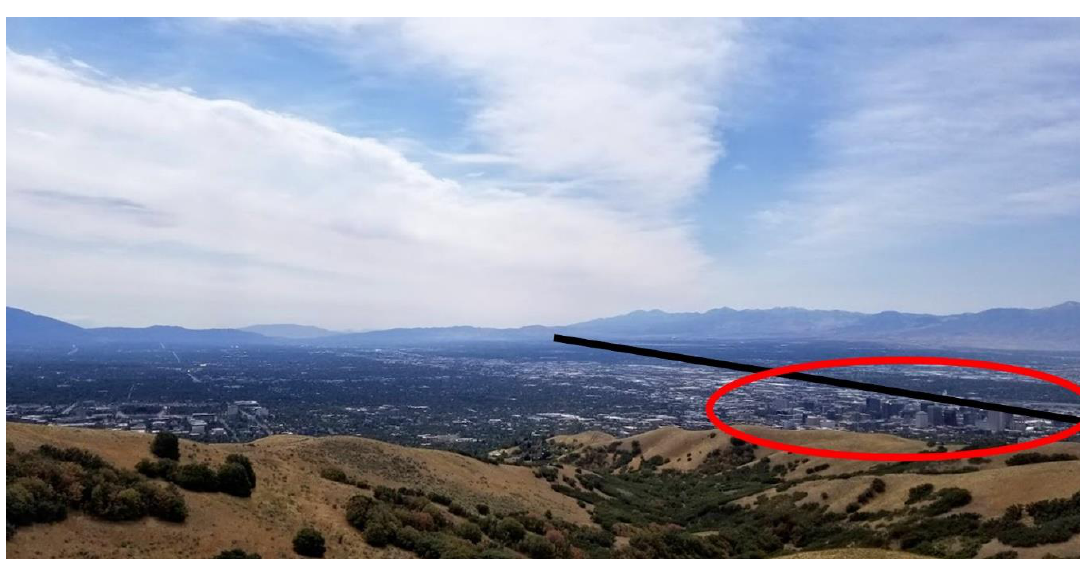
Figure A1. Southwest-facing view of Salt Lake County. The red oval shows the downtown area, and the black line aligns with U.S. Interstate 15 separating the East Side (left) from the West Side (right).